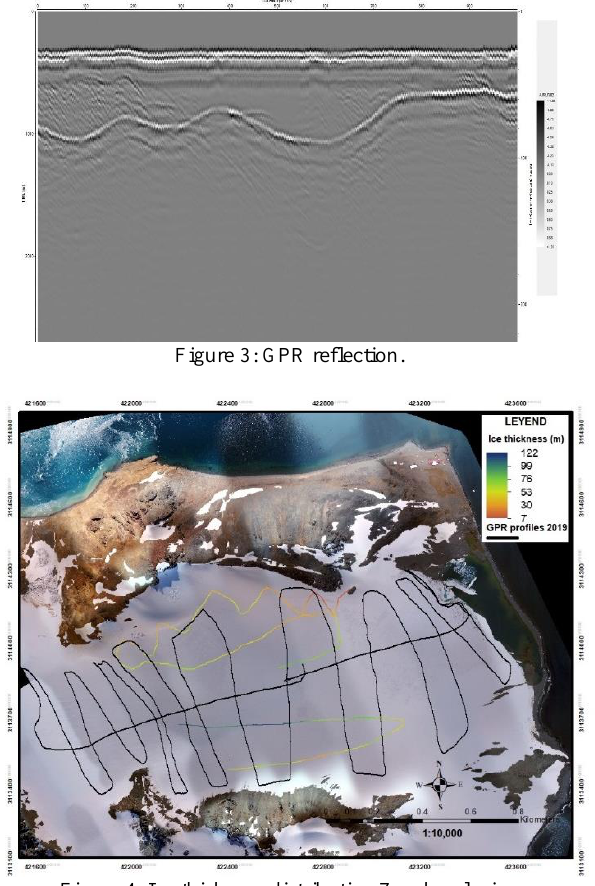
Figure 4. Ice thickness distribution Znosko